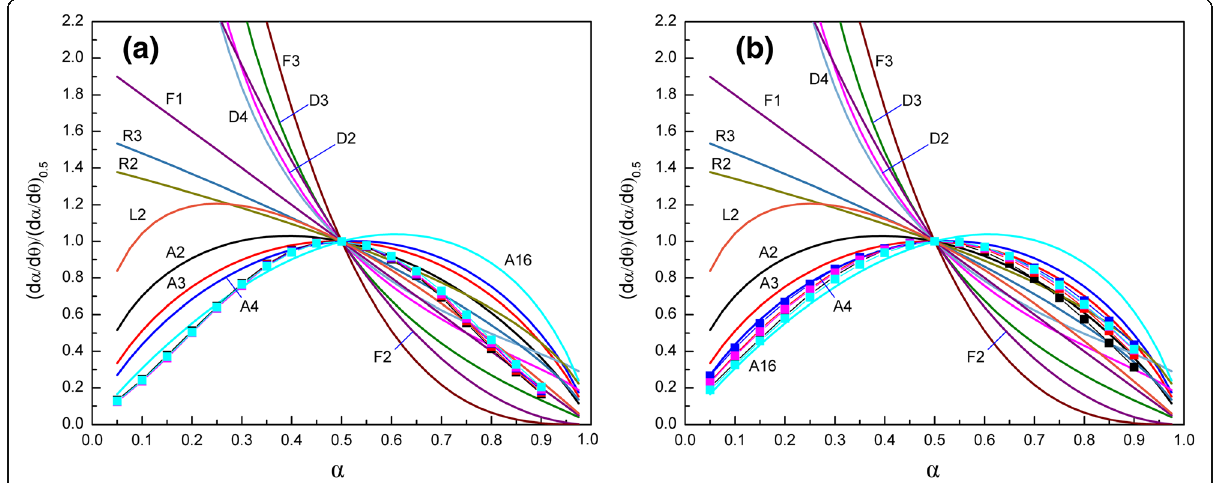
Fig. 9 Theoretical master curves and experimental data obtained using generalized master plots method for ( a ) HCol and ( b ) LCol